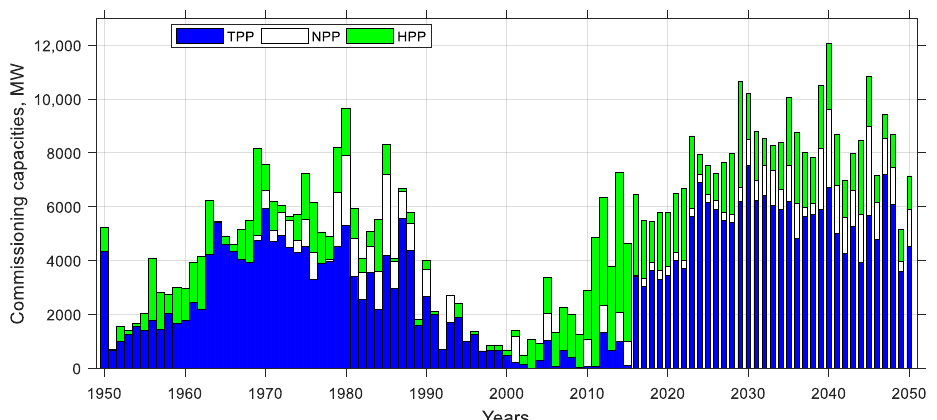
Figure 2. The dynamics of commissioning of capacities of the EPS of Russia in prehistory (1950–2015) and the forecasting period (2016–2050) in the vector